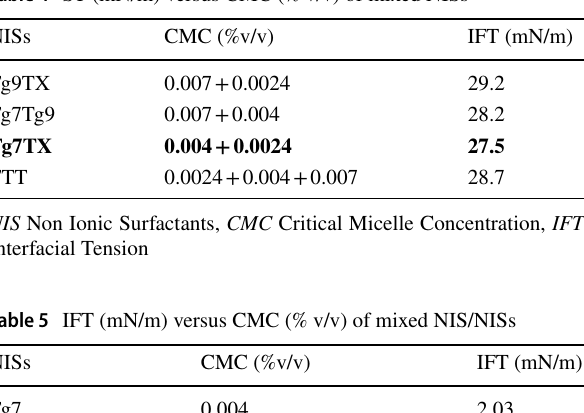
Table 4 ST (mN/m) versus CMC (% v/v) of mixed NISs